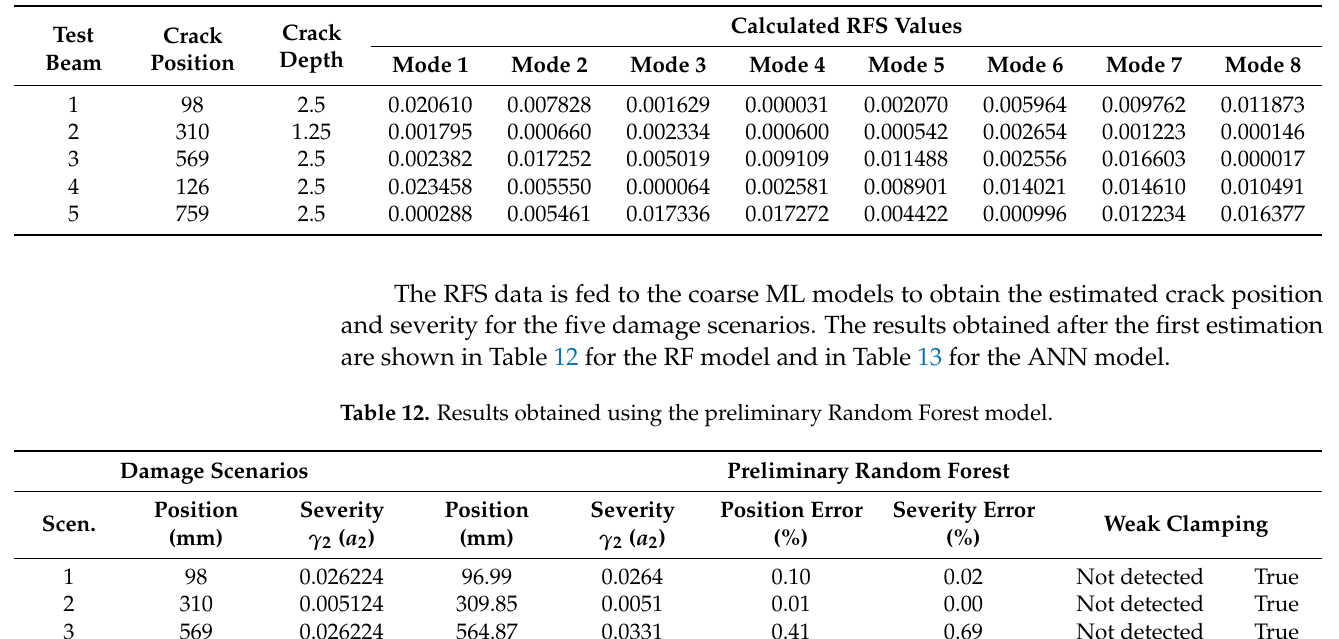
Table 11. Calculated RFS value for each test beam.